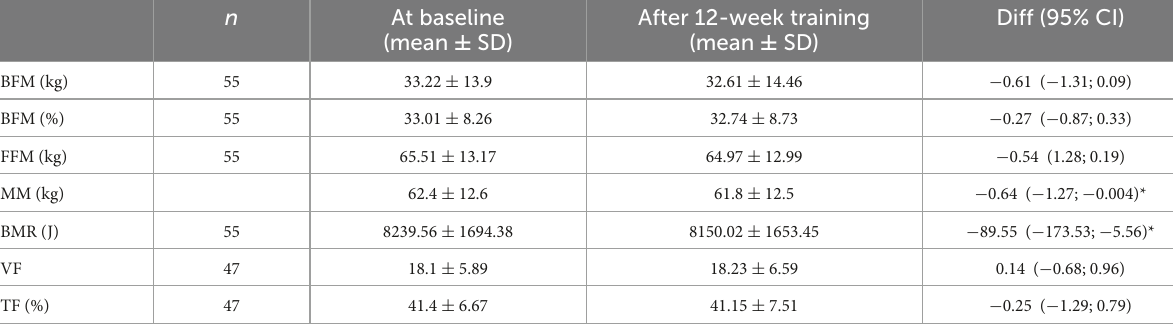
TABLE 3 Body composition parameters at baseline and after the training program. n At baseline (mean ±